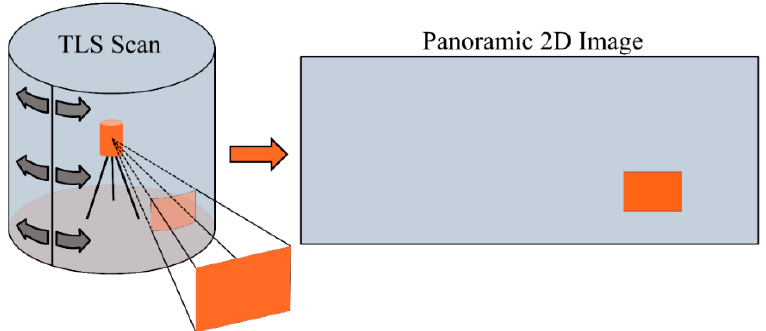
Figure 3. Conceptual depiction of projecting TLS data from native cylindrical coordinate system to panoramic 2D image.